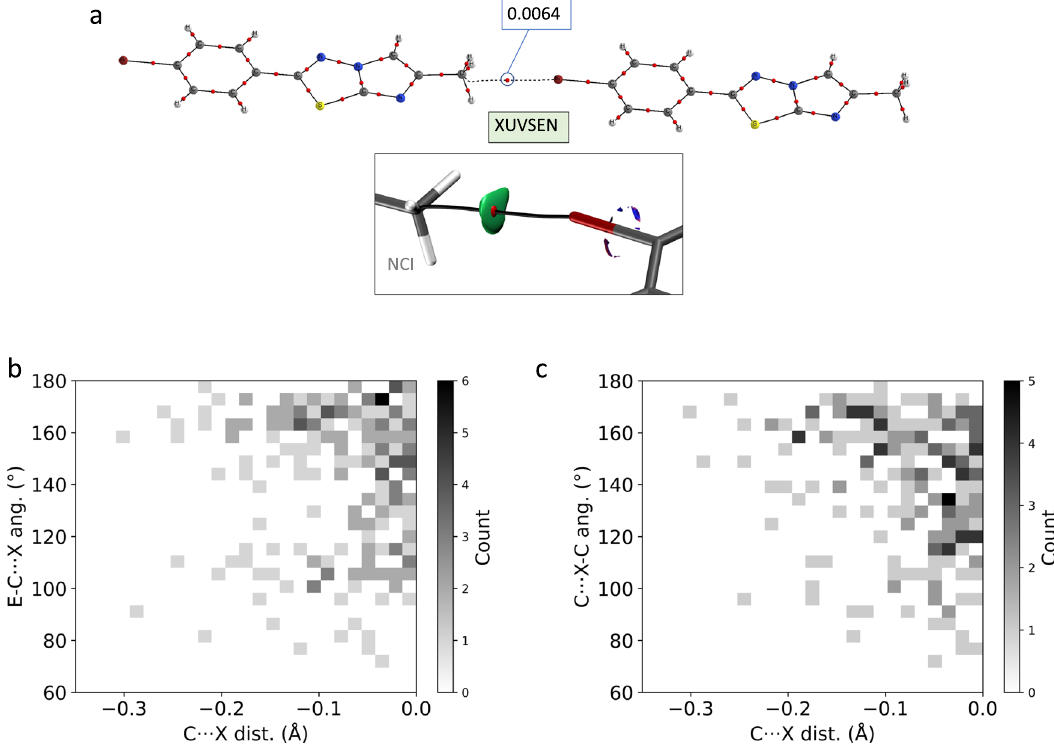
Fig. 7 Halogen bonding. a QTAIM and NCI graph showing the methyl···bromine interaction in the crystal structure of XUVSEN. The values of the electron density at the BCPs are given in a. u. b E-C···X and c C···X-C angles distribution as a function of the C···X vdW-normalized distance for X = Br and I. E can be any group 13, 14 (except C), and 15 (except N) atom. Source data are provided as a Source Data fi